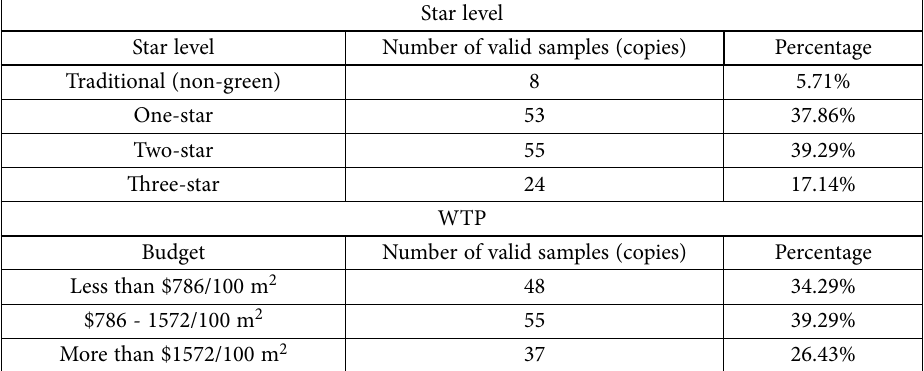
Table 3. Interviewees’ distribution table of retrofit stars and